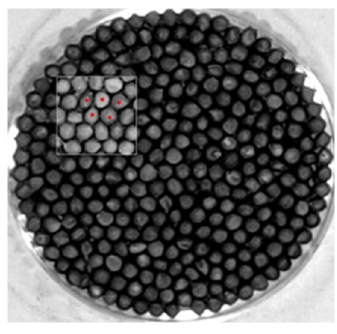
Figure 1. ROI of rapeseed sample. Table 1. Statistical characteristic of oleic acid content rapeseed samples.